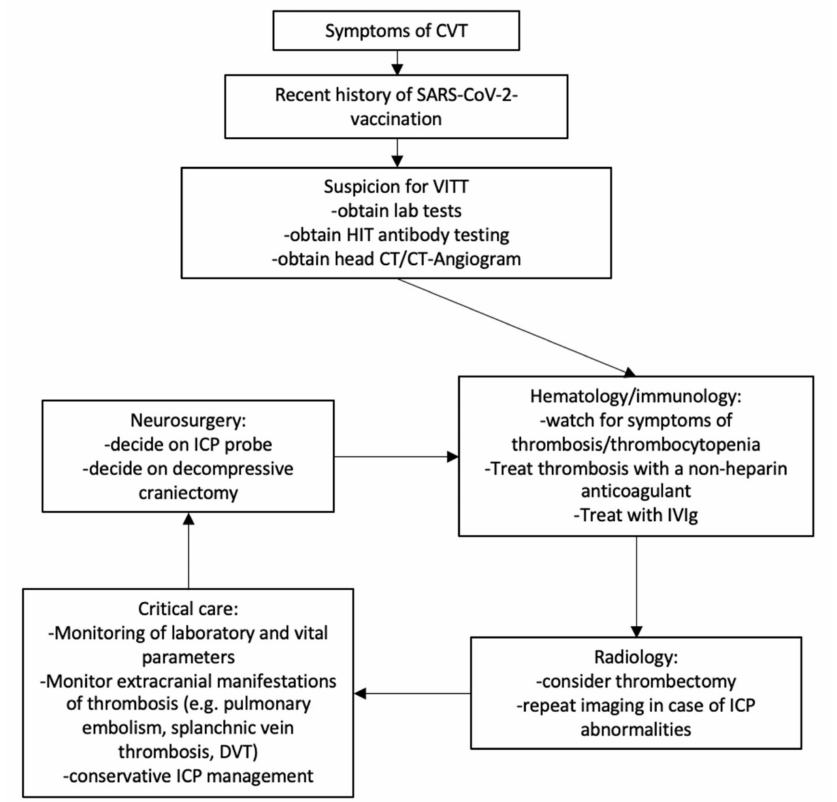
Figure 2. Proposed treatment algorithm in case of VITT-related CVT. When VITT is suspected in patients with symptoms of CVT, diagnostics verifying the diagnosis should be performed. While awaiting results of HIT antibody testing (PF4 ELISA and/or functional assay), patients should be empirically treated for VITT incorporating expertise from relevant